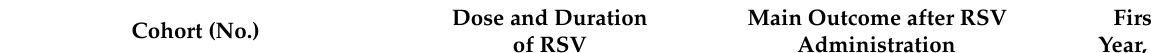
Table 1. Summary of clinical trials involving the use of RSV in